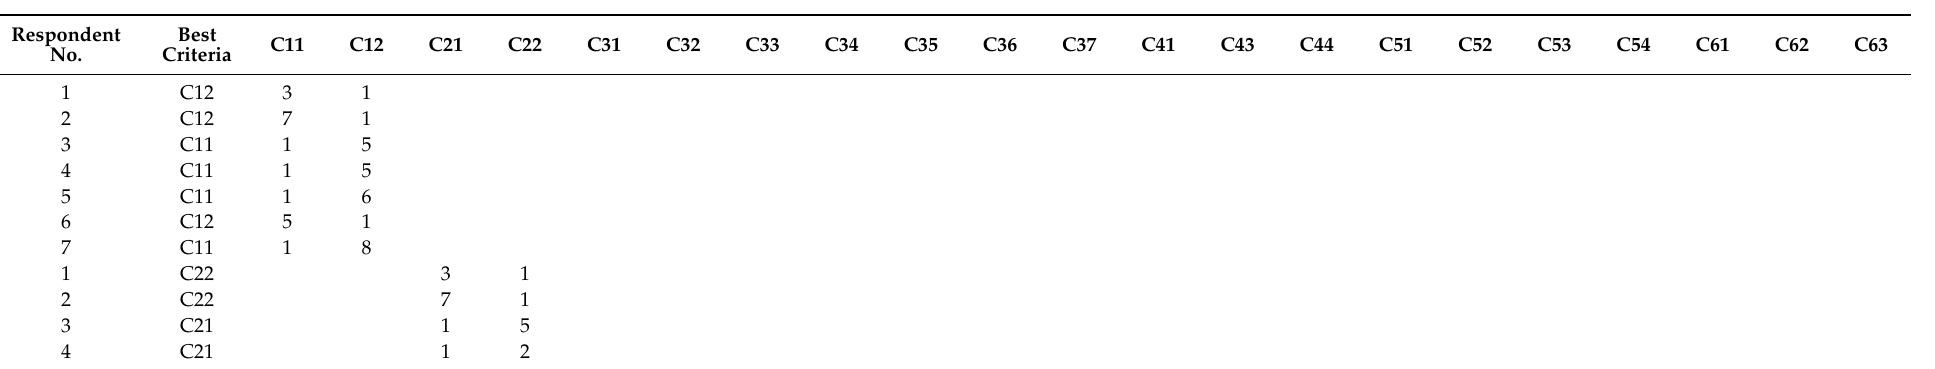
Table 10. BO vectors of